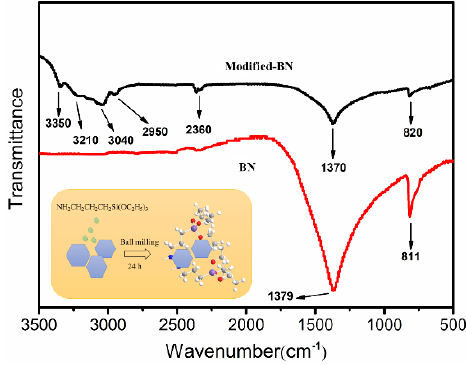
Figure 1. FT-IR spectrum of the modified-BN By KH550.